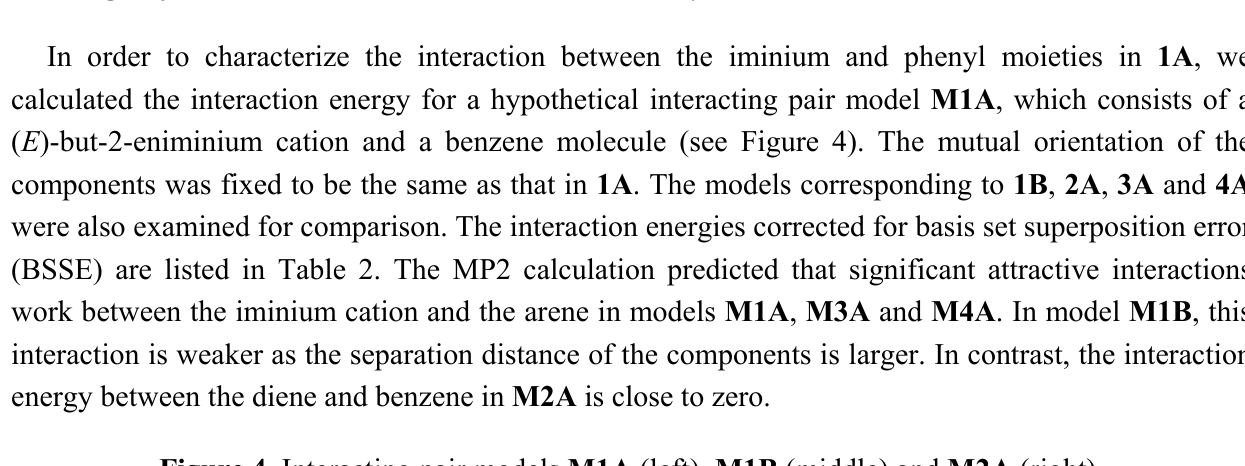
Figure 4. Interacting pair models M1A (left), M1B (middle) and M2A